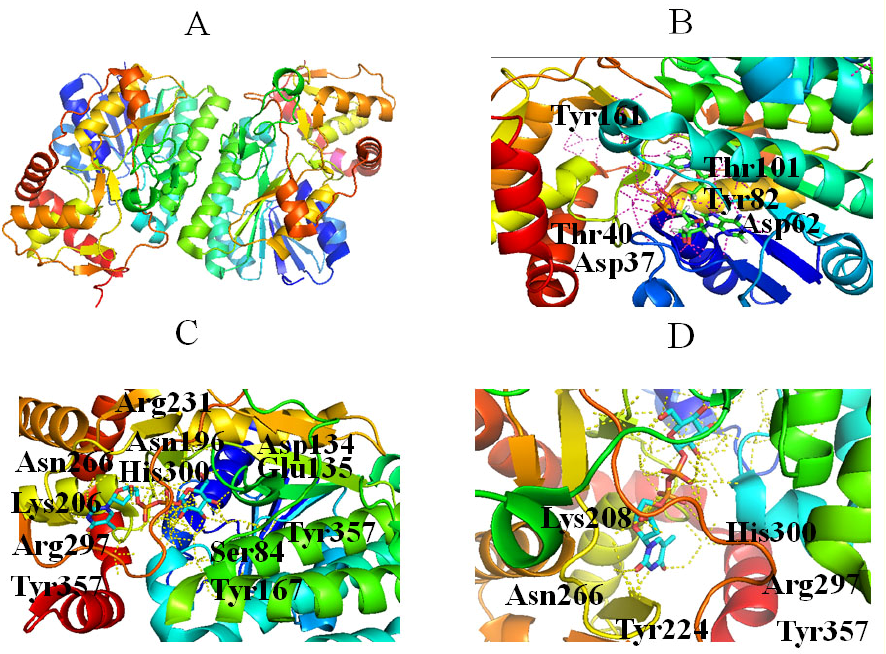
Figure 4. Stereo view of RmlB (PDB entry 1KEP) ( A ), NAD + (PDB entry 1KEP) ( B ), and dTDP-Glc (PDBentry 1KEU) ( C ) bound to RmlB, and the position of the Asn266 side chain as the sugar moves to stack against Tyr224 ( D ). Hydrogen bonds are shown as red lines. Helices, sheets, and loops of RmlB are colored blue, purple, and beige, respectively. C, N, O, and P elements of ligands are green, blue, red, and brown, respectively. RmlB is shown in cartoon representation, and ligands are shown as sticks [22].